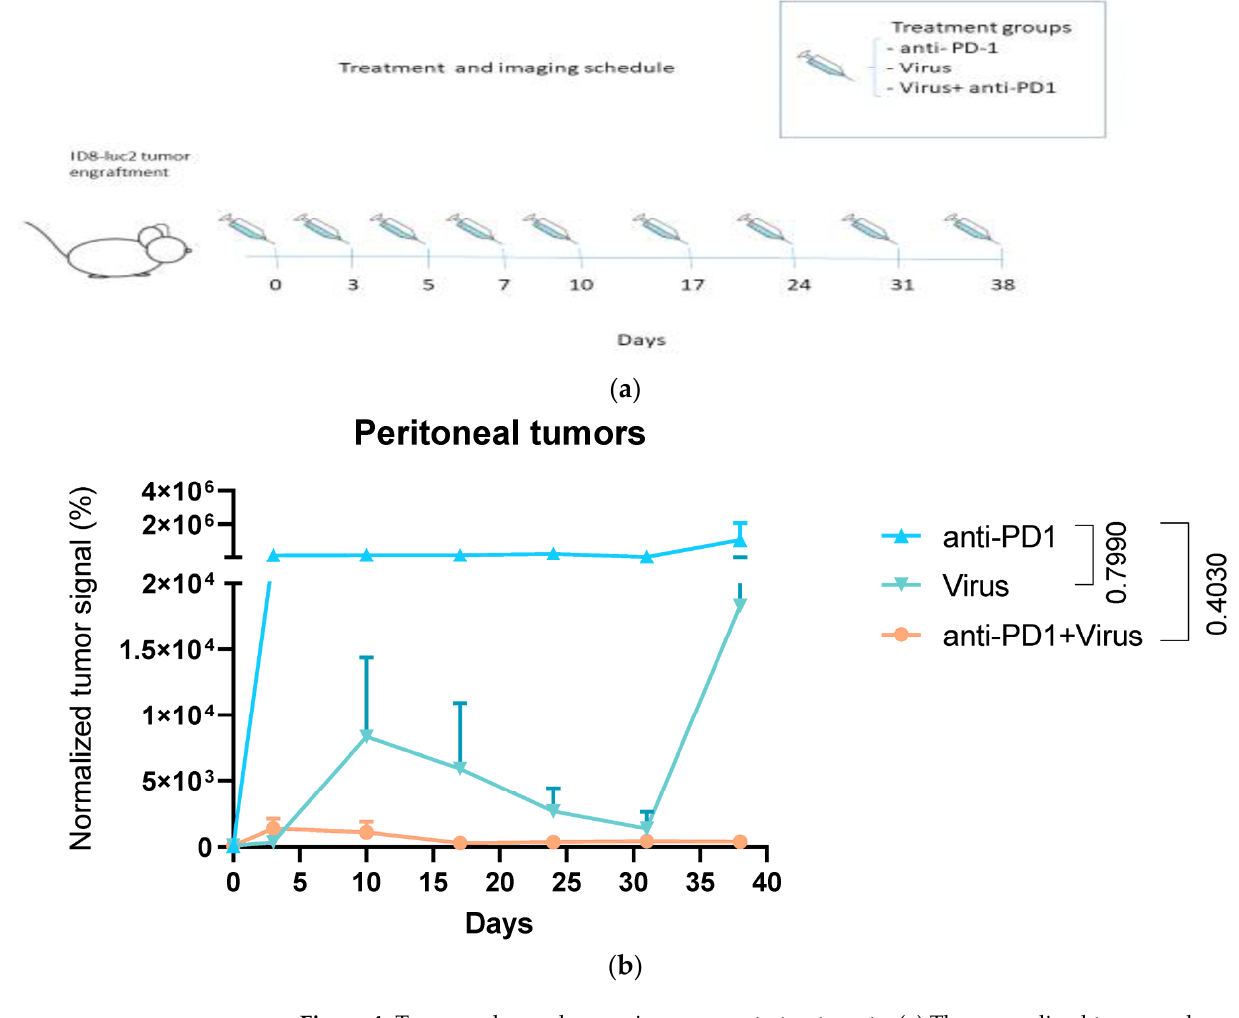
Figure 4. Tumor volume changes in response to treatments. ( a ) The normalized tumor volume was followed according to the schedule described in the picture. ( b ) The animals were imaged by LAGO after an 3 mg luciferin i.p. injection and the normalized tumor signal was calculated by comparison to the tumor signal of the animal on day 0 of treatments. Kruskal-Wallis test was performed on the last day of measurements, N =